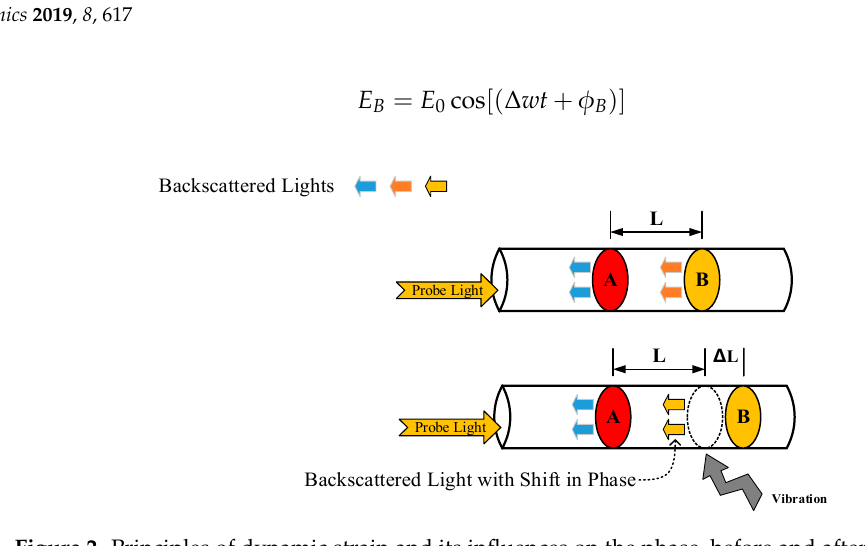
Figure 2. Principles of dynamic strain and its influences on the phase, before and after vibration.